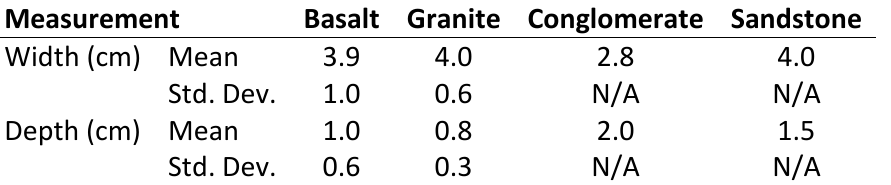
Table 3. Measurements of width and depth between kayé rock types. Abbreviates: N/A - not